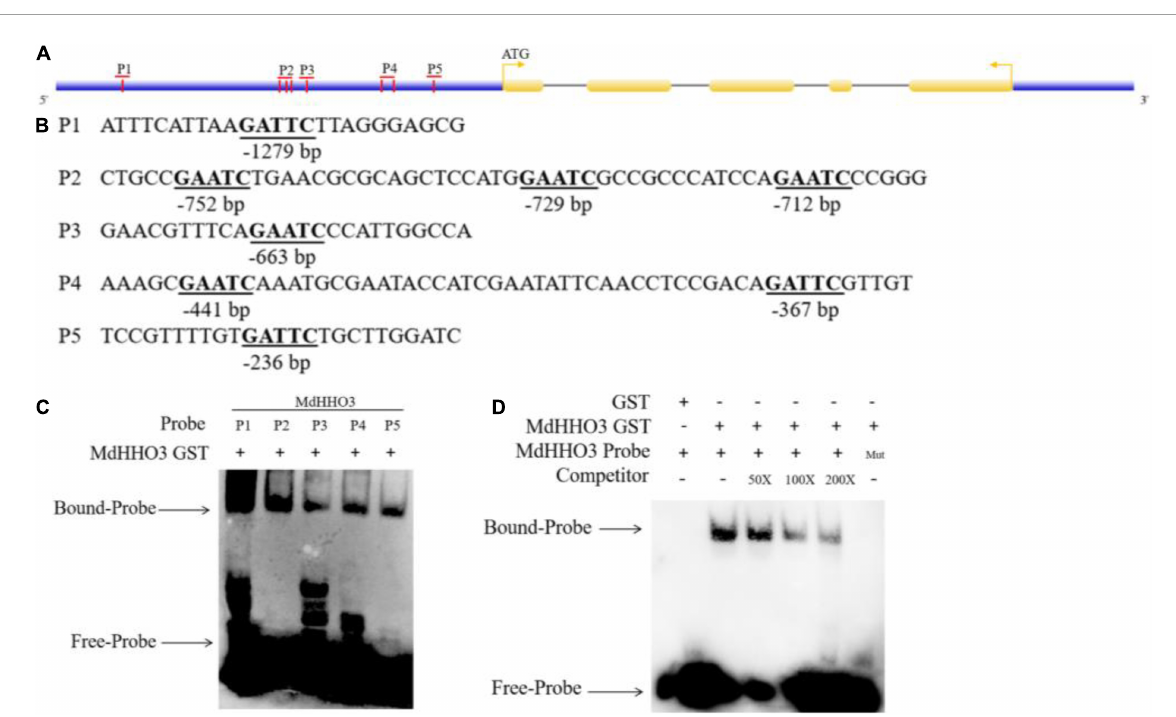
fusion protein bound to the MdNRT2.1 probe (5 (cid:48) -GAATC- 3 (cid:48) ) but not to the mutated probe (5 (cid:48) -CAATG-3 (cid:48) ), and the binding disappeared as the concentration of the